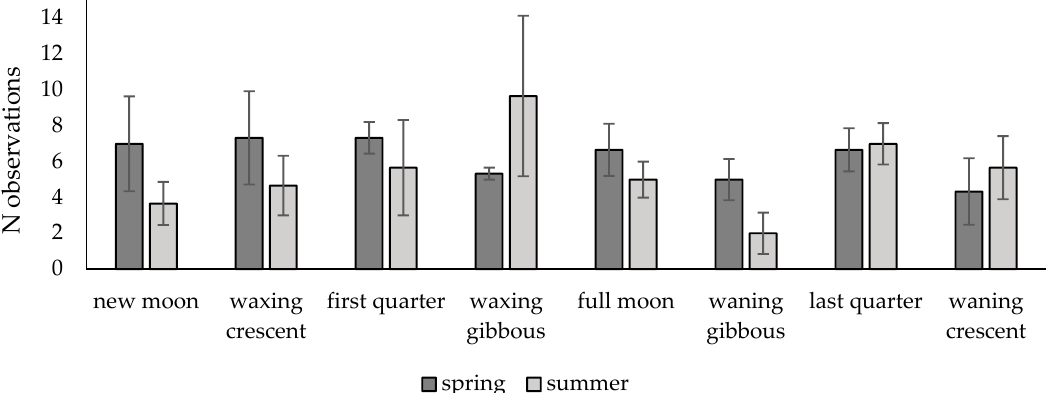
nights was similar (51.3% and 48.7%, respectively, n = 227, χ 2 = 0.13, df = 1, p = 0.721).